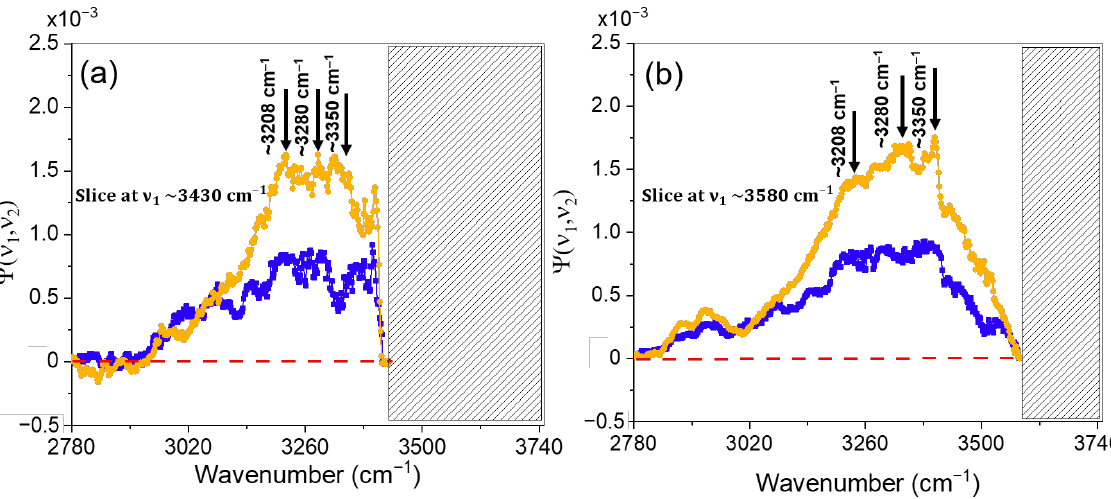
Figure 7. Asynchronous correlation intensity profile calculated along vertical slices characterized by ( a ) 𝜈 1 ~3430 cm −1 and ( b ) 𝜈 1 ~3580 cm −1 for Coum/SBE-β-CD inclusion complex (orange circles) and physical mixture (blue squares). The red dashed line accounts for the Ψ(𝜈 1 ,𝜈 2 )~0 condition. Thus, positive and negative correlations develop above and below this line. Considering the region of the 2DAM which satisfies the 𝜈 1 > 𝜈 2 condition (see text for details), information originating from the upper-side portion of the 2D map with respect to the diagonal line must be excluded (black hatched bars). Black arrows indicate 𝜈 2 values of interest for our discussion.